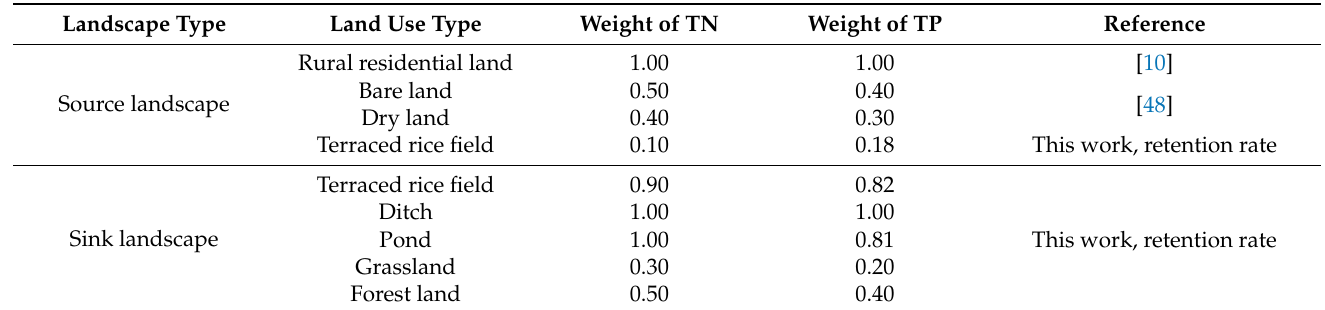
Table 2. Classification and weight of source- and sink-type landscape areas in the Hani rice terrace